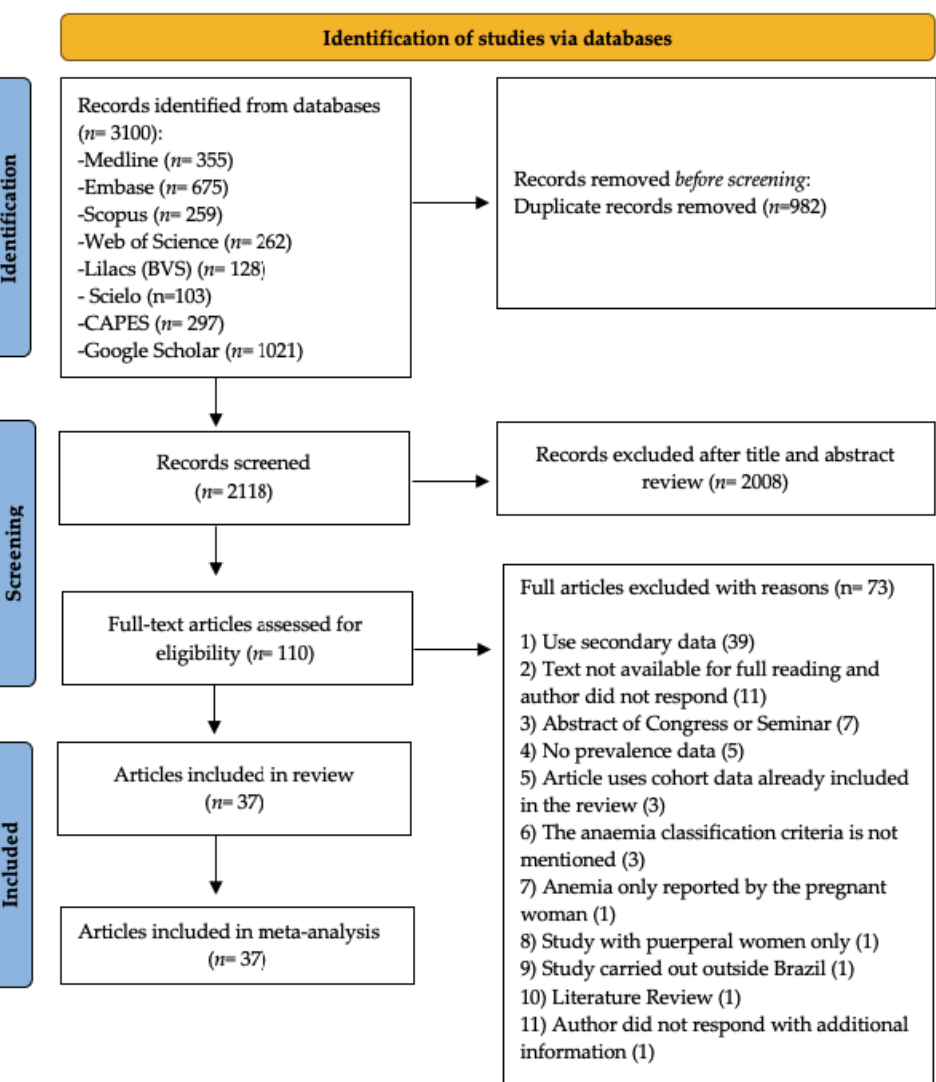
Figure 1. Flowchart of the study selection process. Adapted from PRISMA.